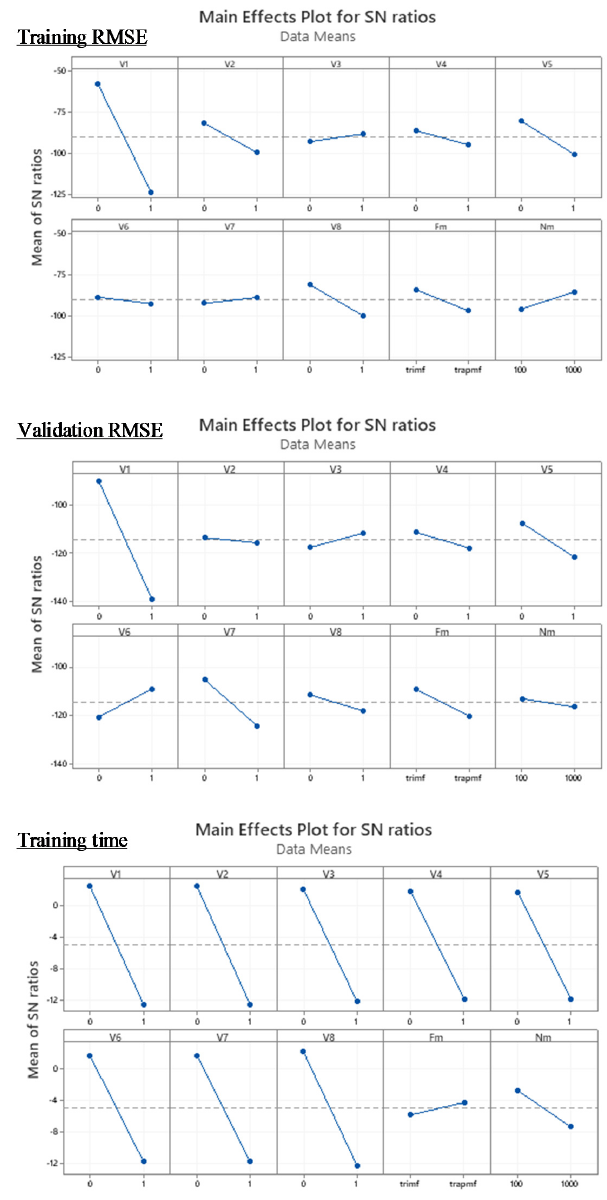
Figure 5. Main effect plots for signal-to-noise ratios in demand forecasting. Figure 5. Main e ff ect plots for signal-to-noise ratios in demand